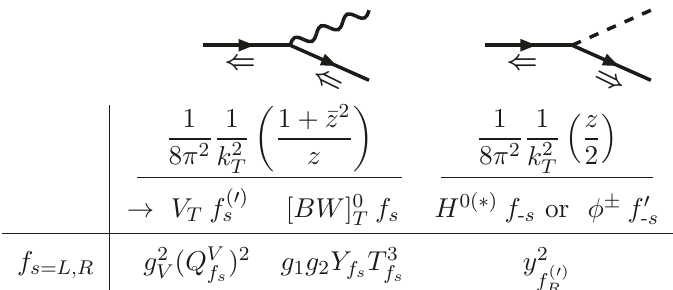
Table 1. Chiral fermion splitting functions d /dz dk 2 in the massless limit, with z (¯ z 1 z ) T P ≡ − labeling the energy fraction of the first (second) produced particle. The fermion helicity is labelled by s . Double-arrows in Feynman diagrams indicate example fermion helicity directions. Prime indicates isospin partner ( u ′ = d s , etc, independent of s ). Yukawa couplings are labelled by the s participating RH-helicity fermion. The state H 0 ∗ is the “anti- H 0 ”, produced when the RH fermion is down-type and in the initial-state, or up-type in the final-state. Processes with B 0 and W 0 implicitly represent the respective diagonal terms in the neutral gauge boson’s density matrix, whereas [ BW ] 0 indicates either of the off-diagonal terms (see text). Anti-fermion splittings are obtained by CP conjugation. The conventions for the couplings are given in B.1.